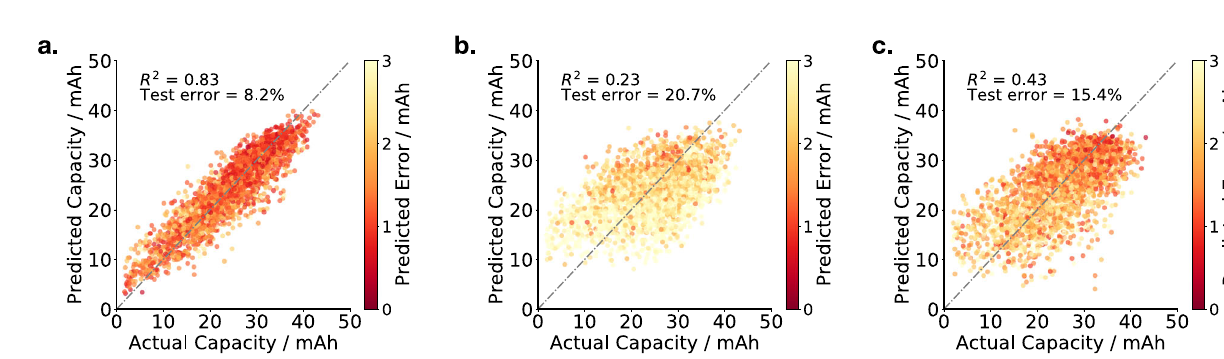
Fig. 3 | Predicting next cycle discharge capacity. a Given knowledge of the state (the battery's internal state, as characterised by the EIS spectrum) and the action (the next cycle charge/discharge protocol), our model predicts the next cycle